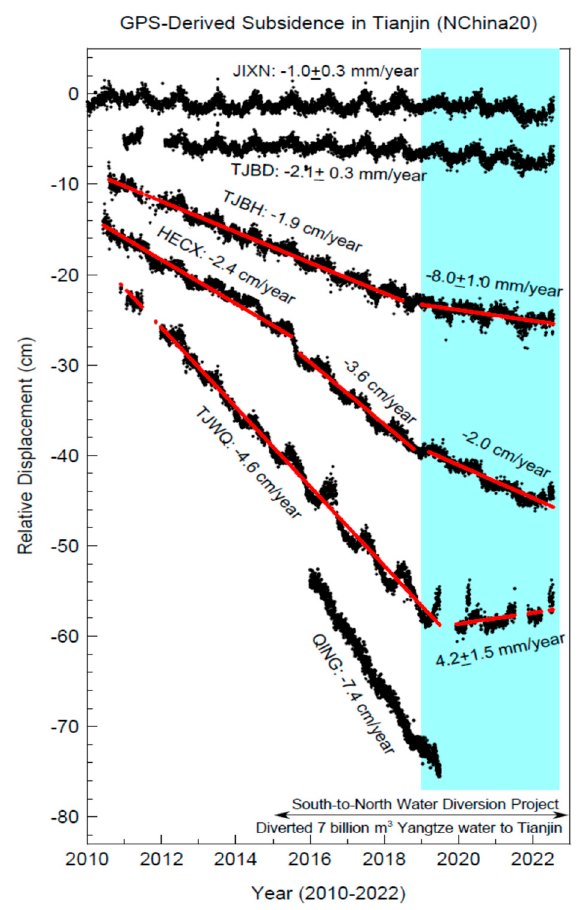
Figure 5. GPS-derived daily subsidence time series at five sites (JIXN, TJBD, TJBH, TJWQ, QING) in Tianjin and one site (HECX) in Cangzhou, Hebei Province. The locations of these GPS sites are marked in Figure 1.